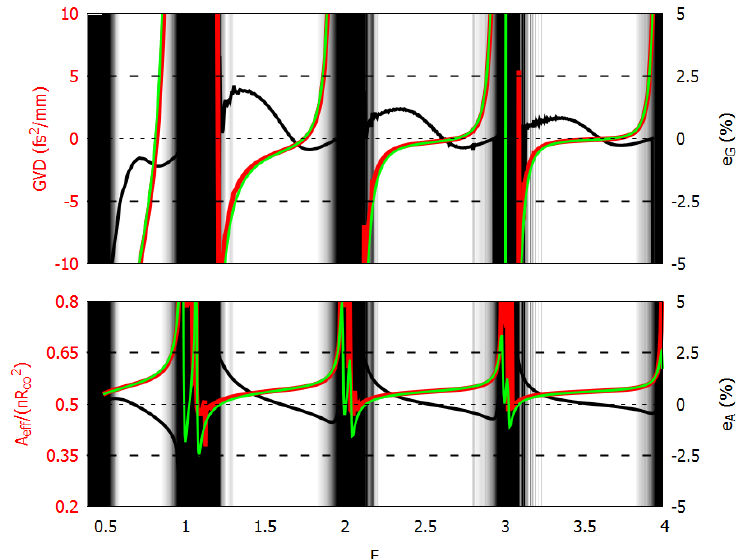
Figure 4. Group velocity dispersion ( top ) and effective area ( bottom ) of fiber F#1. Dark regions correspond to high-loss regions. In both graphs, solid green, red, and black curves show numerical and analytical result, and relative error,